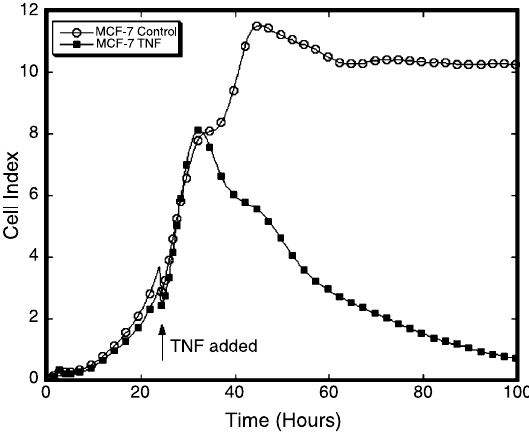
Fig. 1. MCF-7 human breast cancer cell line given 2.5nM TNF- alpha 24 hours after seeding the cells in the E-plate. After 7–8 hours, the TNF-treated cells begin to undergo apoptosis, round up, and eventually detach from the plate, causing the loss in impedance.